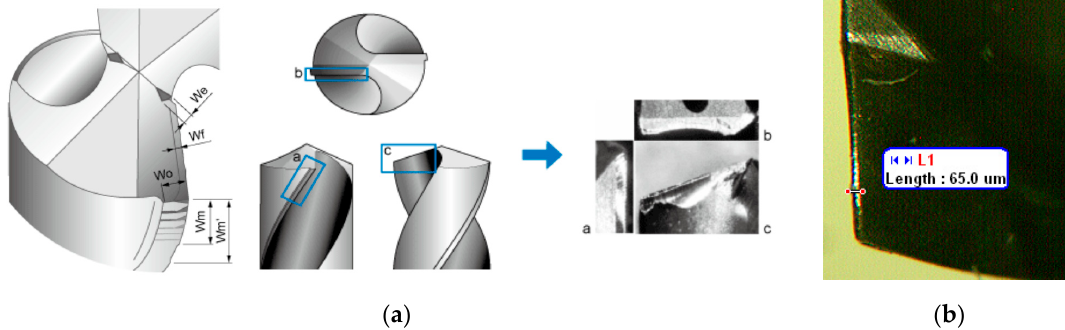
Figure 3. ( a ) Wear parameters in drilling and common locations (a. Secondary cutting edge; b. Main cutting edge, flank face; c. Main cutting edge, rake face), courtesy of Mitsubishi©; ( b ) Wear measurement on the rake face.